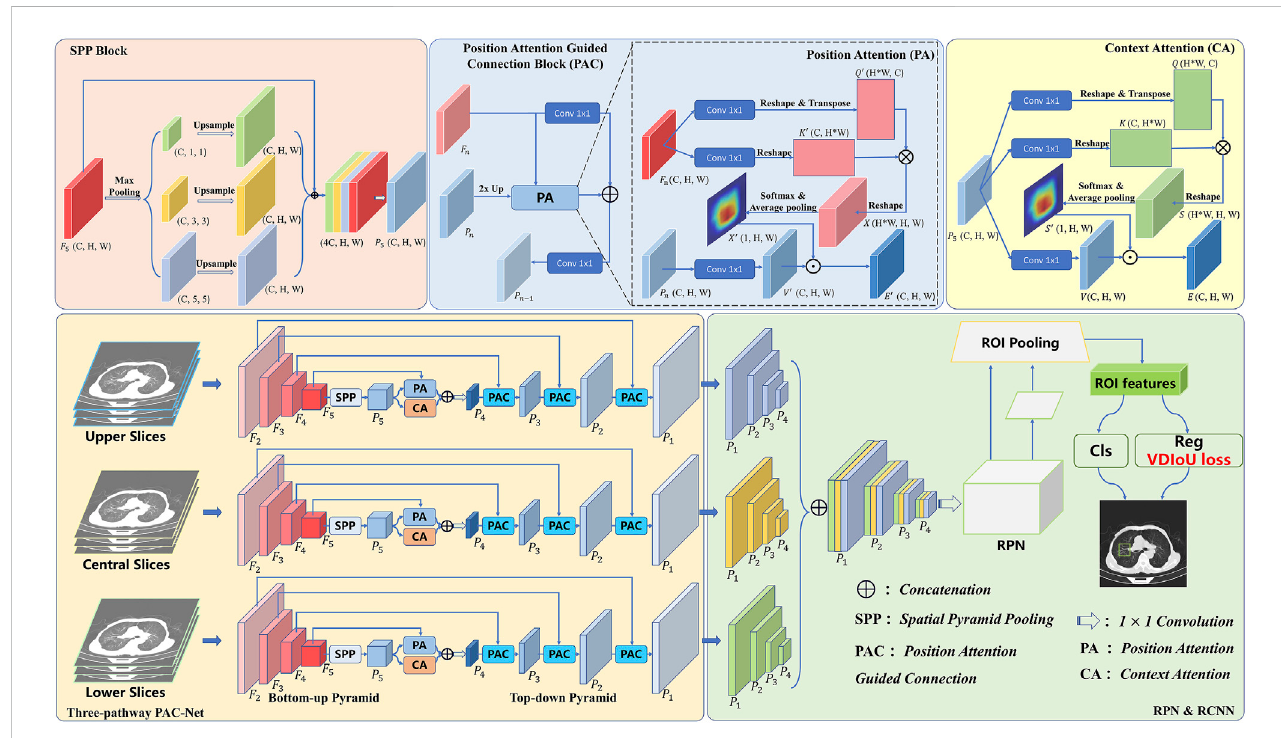
FIGURE 1 Overview of incorporating PAC-Net into Faster R-CNN for 3D medical image